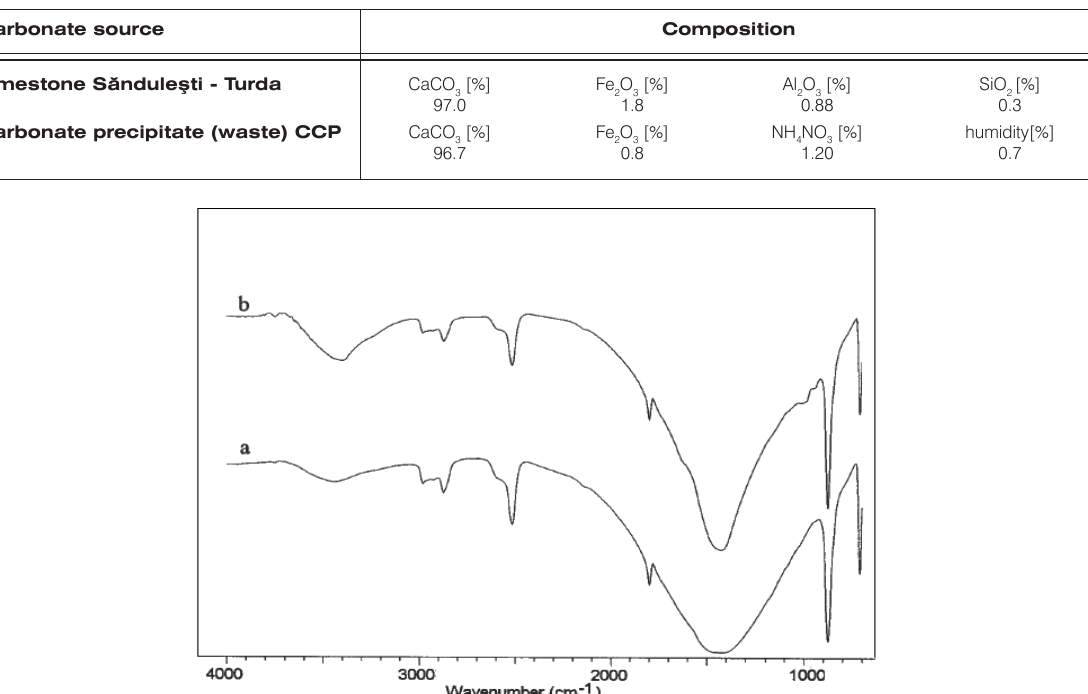
Table 1. Composition of limestone and calcium carbonate precipitate.